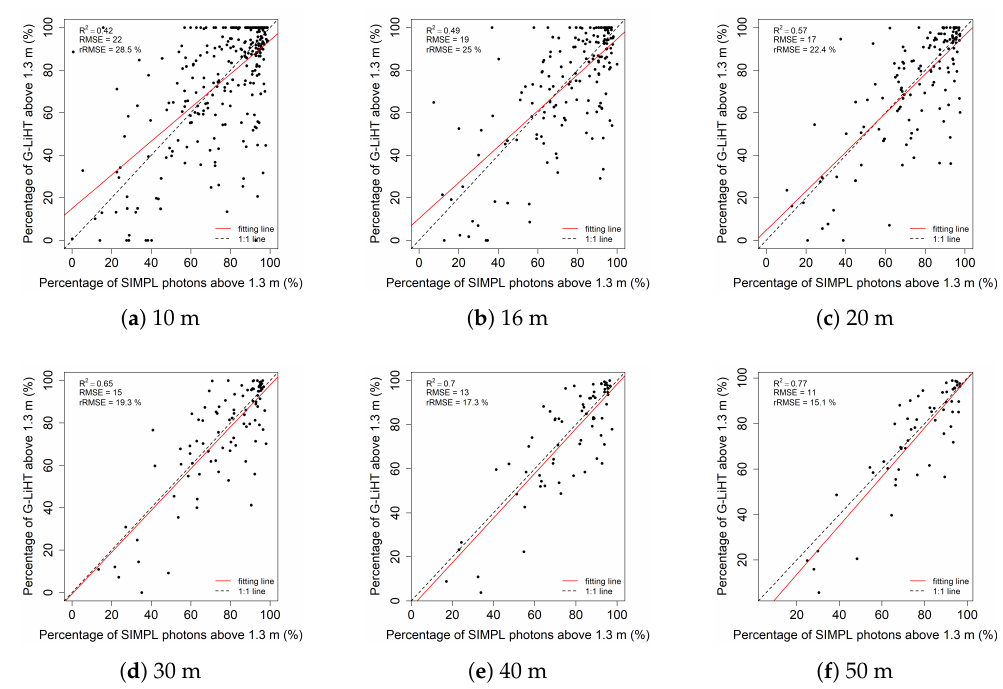
Figure 12. The relationship between the fraction of the number of photons above 1.3 m from SIMPL and the fraction of the number of points above 1.3 m from G-LiHT for different scales.